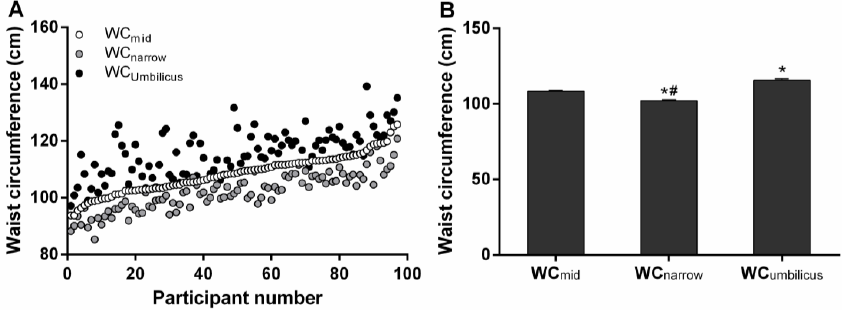
Figure 1. Waist circumference (WC) measurement at different sites. WC at the midpoint (WC mid ), narrowest point (WC narrow ) and umbilicus (WC umbilicus ) for each individual participant ( A ); and as means ± SEM ( B ), in postmenopausal women with obesity ( n = 97). * p < 0.05 versus WC mid , # p < 0.05 versus WC umbilicus.